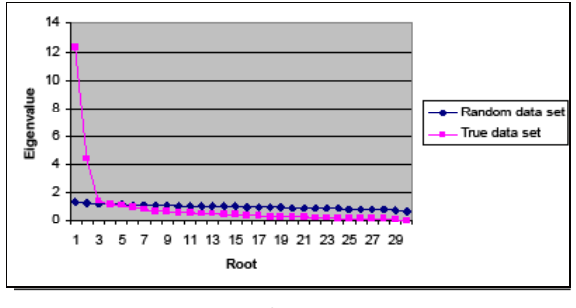
FiGure 1 Scree plot for the item-level factor analysis in respect of the total group